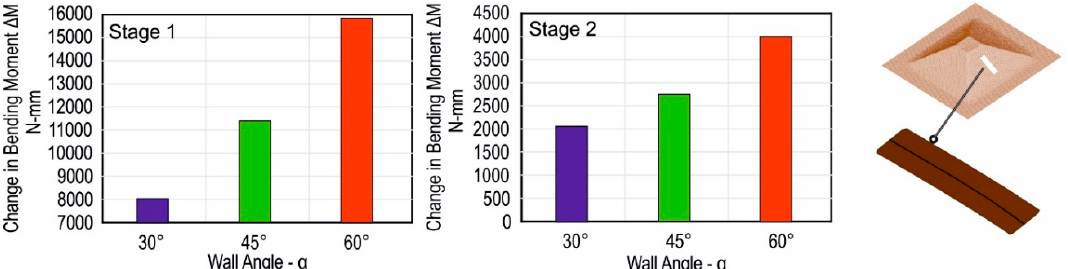
Figure 14. Change in the bending moment for different wall angles upon unclamping (Stage 1) and upon trimming (Stage 2) along a